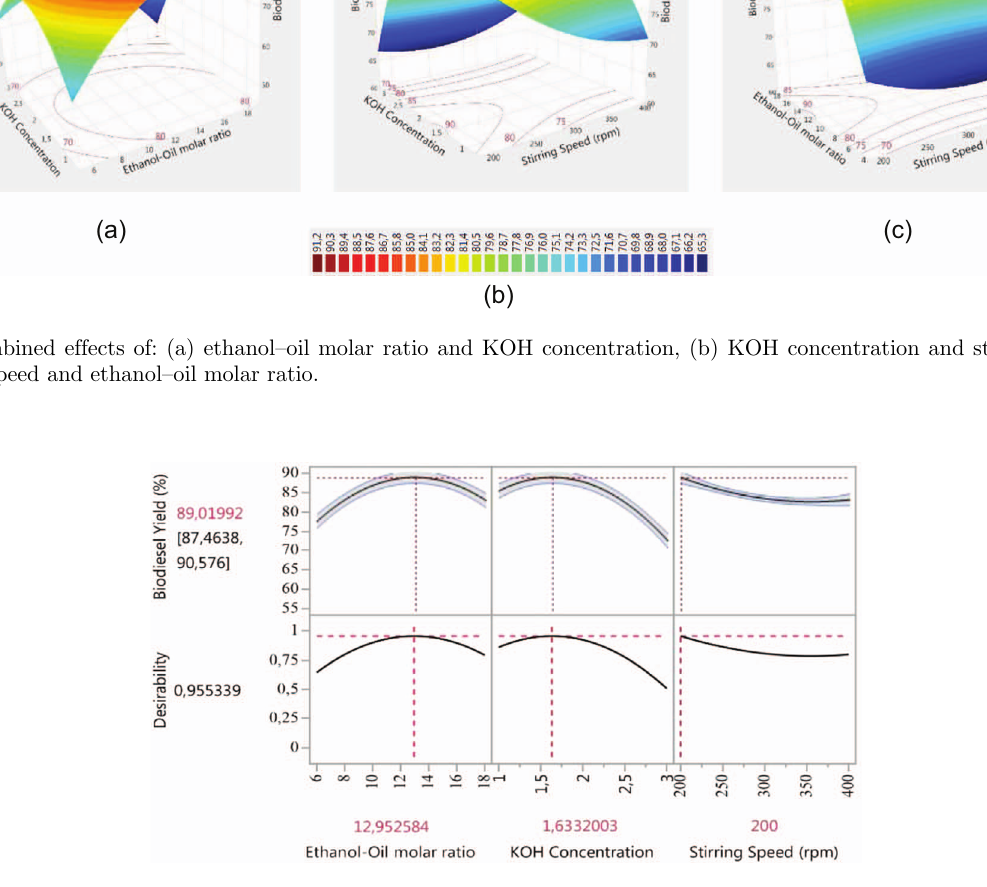
Fig. 4. Optimization of multiple responses by composite desirability function.